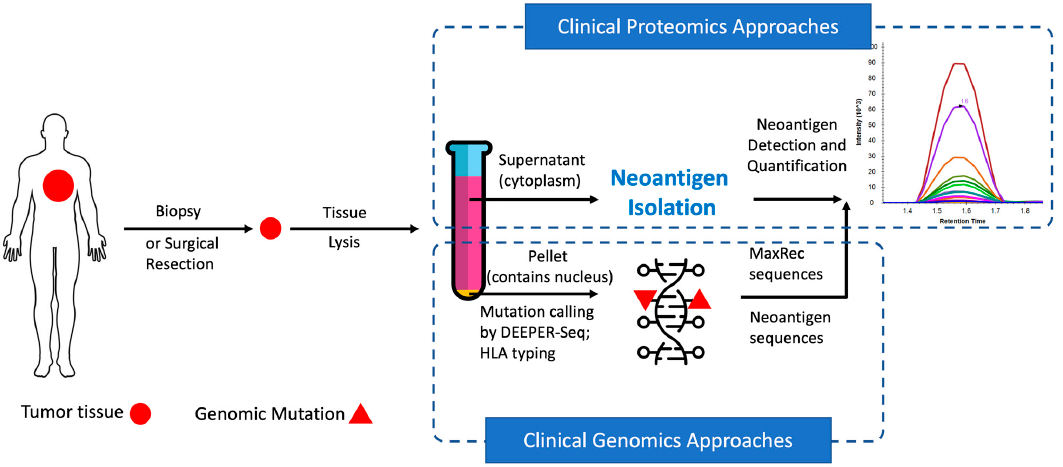
Figure 1. Valid-NEO multi-omics assay pipeline.